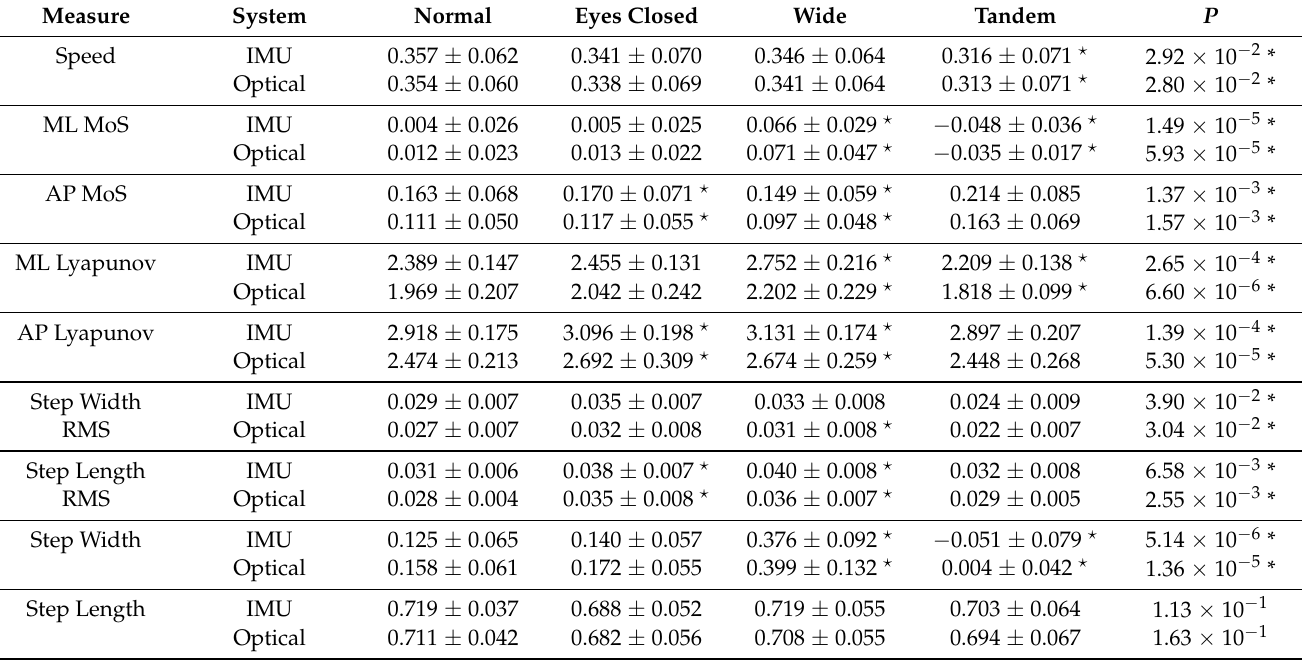
Measures shown as mean ± s.d. across participants ( N = 10) and reported in dimensionless units. Statistical significance of each measure indicated by an asterisk (*) calculated from repeated measures ANOVA ( P < 0.05). Statistical significance based on post-hoc t-tests with Holm–Sidak correction with Normal as the control condition indicated by ( (cid:63) ). MoS, margin of stability; IMU, inertial measurement unit; RMS, root-mean-square.